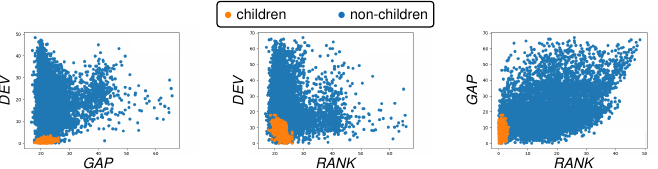
Figure 3. Scatter plots for tandems of the penalty terms DEV , GAP , and RANK . We mark in orange the true children pairs and in blue invalid children pairs. These plots allow us to identify appropriate empirical thresholds to trim the (considered synthetic) data in order to reduce the computational complexity of the parent–children